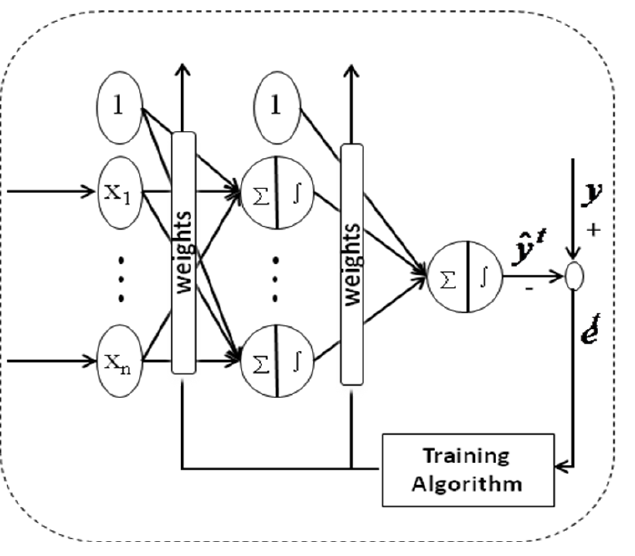
Figure 1 . MLP based forecasting